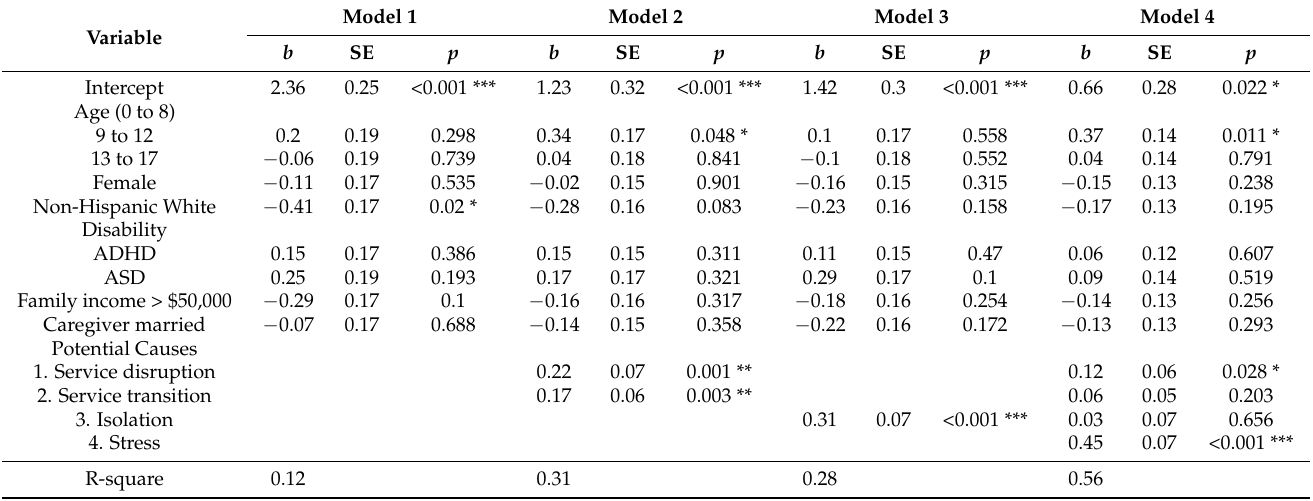
Table 4. OLS regression models predicting children’s behavioral and emotional deterioration ( n =